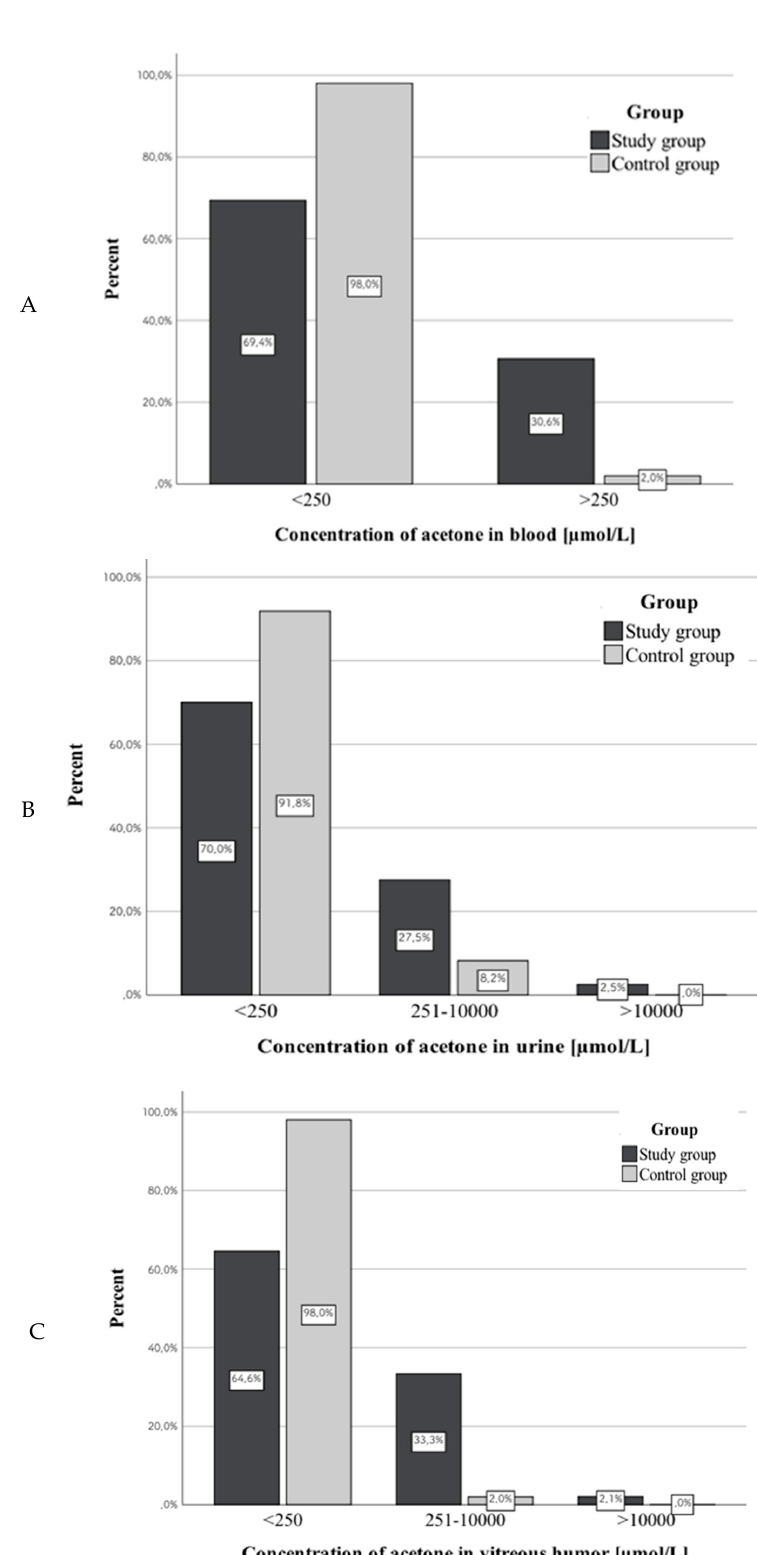
Figure 1. Correlations between the compared groups of subjects and acetone concentration in blood ( A ), urine ( B ), and vitreous humor ( C ). ( A ), urine ( B ), and vitreous humor ( C